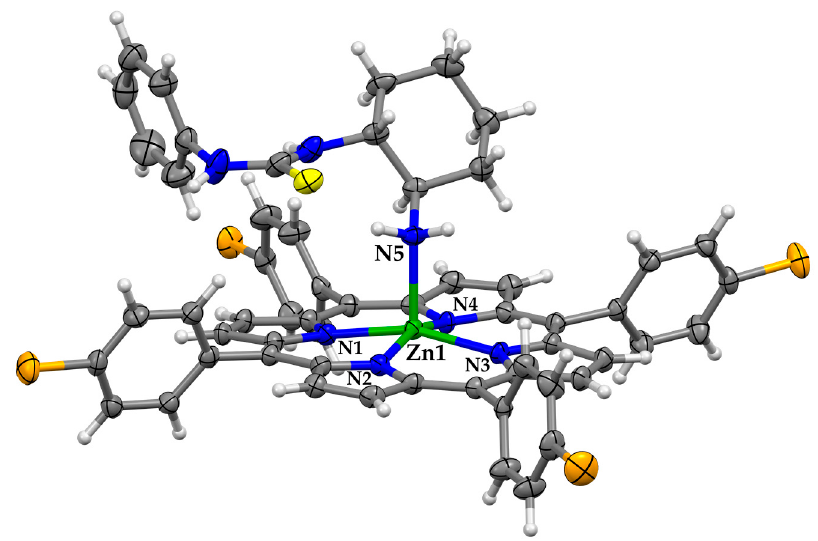
Figure 4. Displacement ellipsoid plot of the ( R , R )- 1b · P5 complex. Displacement ellipsoids are drawn at the 50% probability level. The co-crystallized CH 2 Cl 2 molecule has been omitted for clarity. Selected interatomic distances (Å): Zn1 ⋯ N1 2.075(4), Zn1 ⋯ N2 2.080(4), Zn1 ⋯ N3 2.070(3), Zn1 ⋯ N4 2.075(4), Zn1 ⋯ N5 2.131(3).